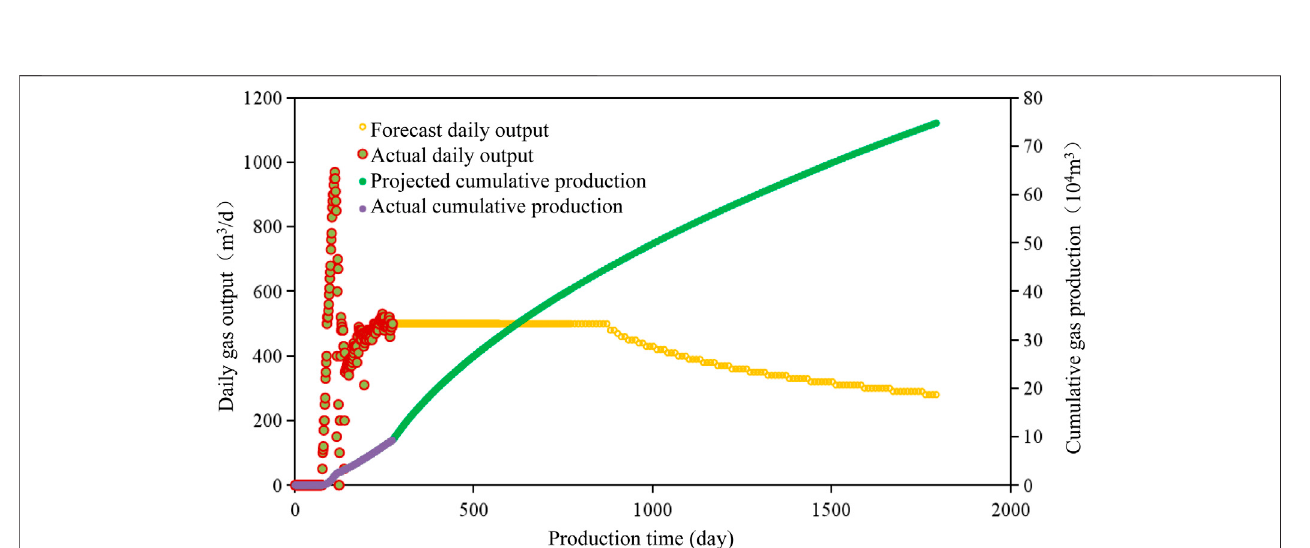
FIGURE 2 | Historical fi tting and production prediction of well Ma 26 in No. 15 coal seam of the Mabidong block.